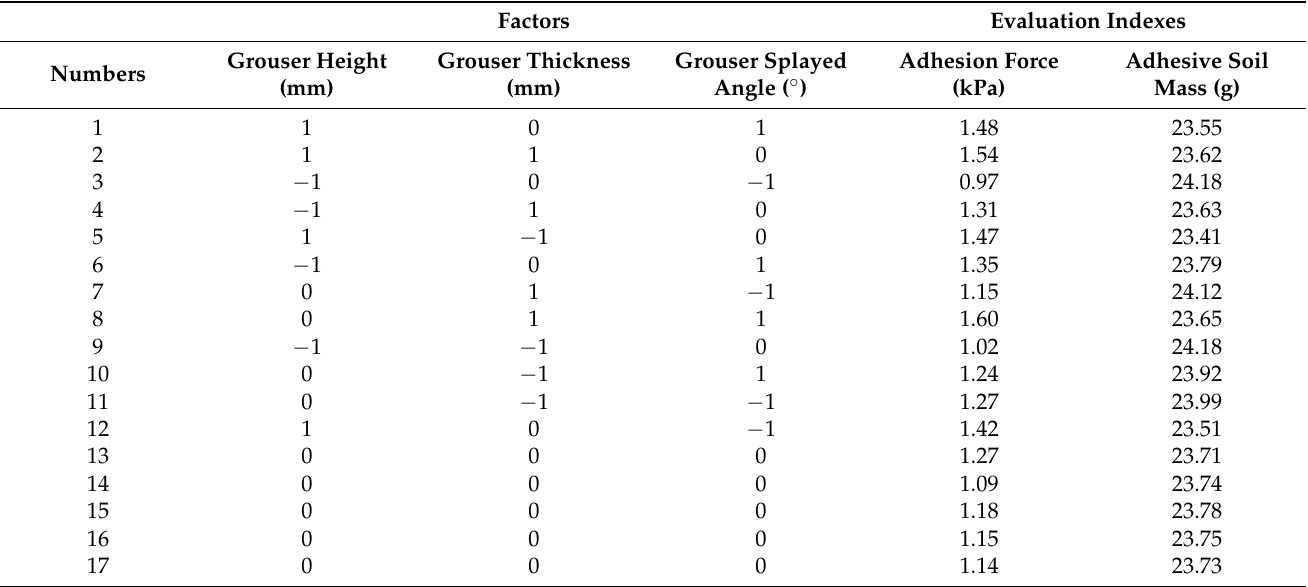
Table 3. The experimental scheme and results.